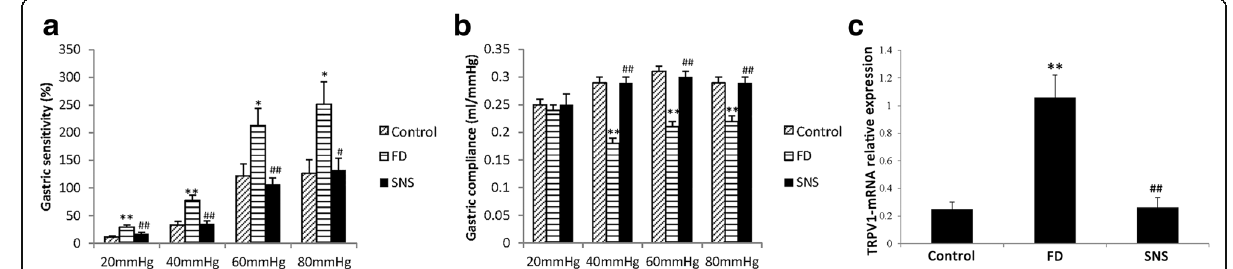
Fig. 1 Visceral sensitivity ( a ), gastric compliance ( b ) and mRNA expression of TRPV1 ( c ). The model group had elevated visceral sensitivity and decreased gastric compliance compared with the control group. SNS treatment was effective to recover the visceral sensitivity and gastric compliance. The mRNA level of TRPV1 was notably increased in the duodenum of the model group compared with the control group, and the SNS treatment decreased the expression of TRPV1. All data were represented as mean ± SEM (6 rats in each group). * P < 0.05 compared with the control group; ** P < 0.01 compared with the control group; # P < 0.05 compared with the model group. ## P < 0.01 compared with the